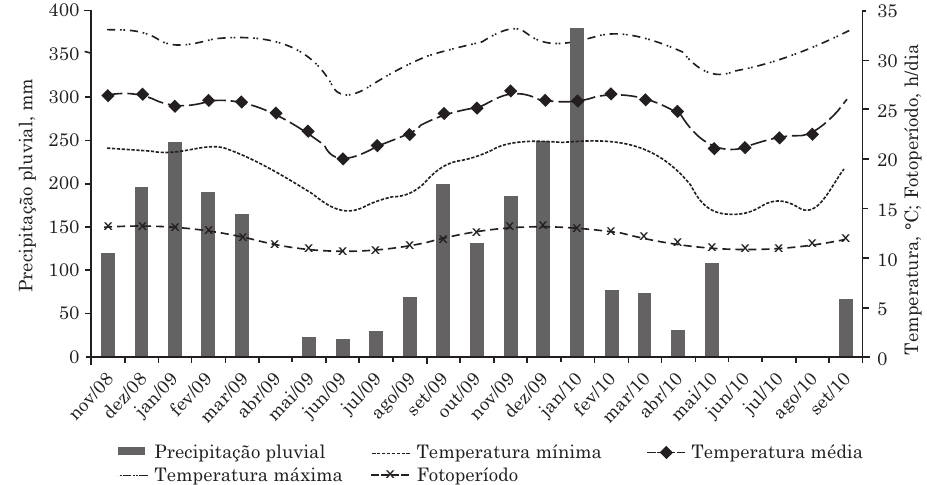
Figura 1. Dados climáticos obtidos da estação meteorológica situada na Fazenda de Ensino, Pesquisa e Extensão da FE/UNESP, no município de Selvíria, Mato Grosso do Sul. Período de novembro/2008 a